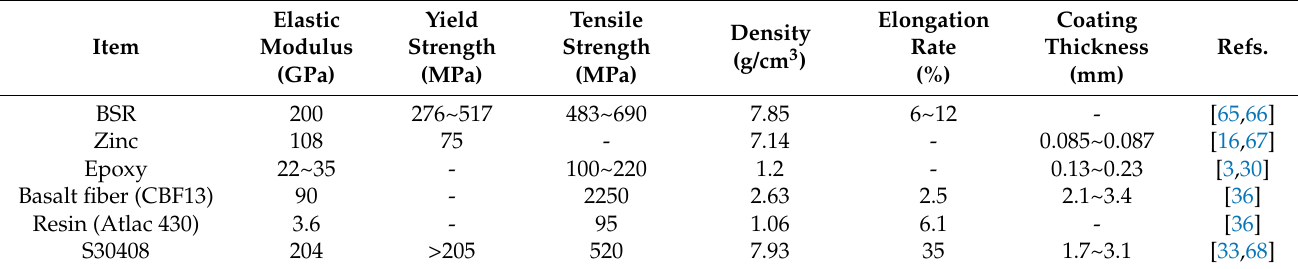
Table 1. Properties of components of coated reinforcements.